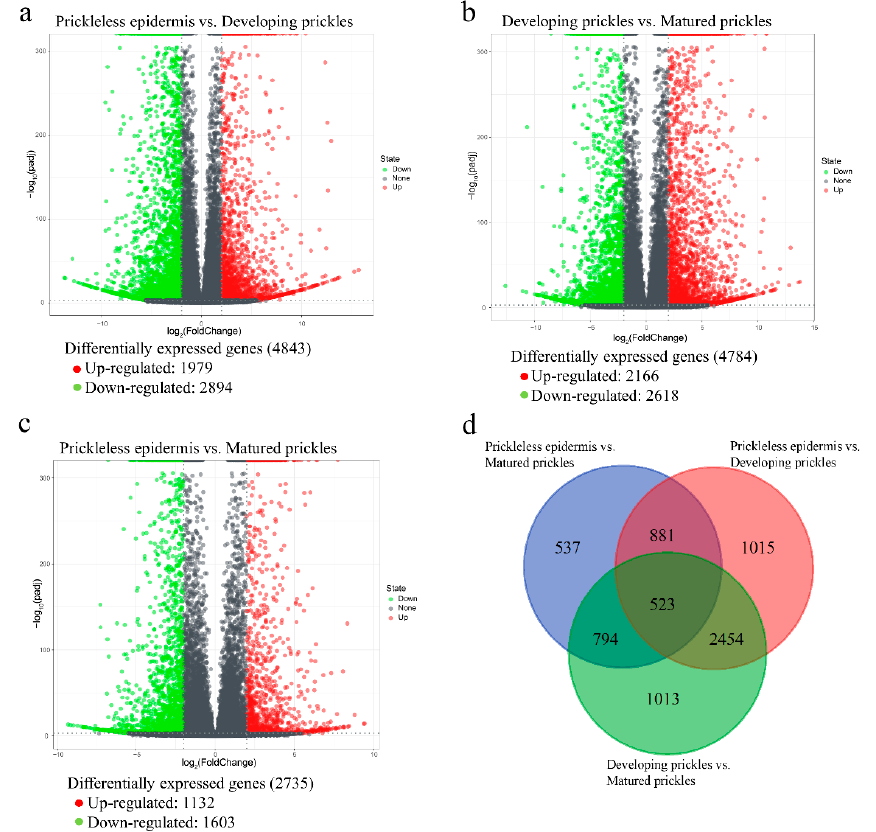
Figure 3. Volcano plots and Venn diagram of DEGs in the pairwise comparisons. ( a ) Volcano plot of DEGs in the prickleless epidermis vs. developing prickles comparison; ( b ) Volcano plot of DEGs in the prickleless epidermis vs. matured prickles comparison; ( c ) Volcano plot of DEGs in the developing prickles vs. matured prickles comparison; ( d ) Venn diagram of the number of DEGs in the pairwise comparisons.